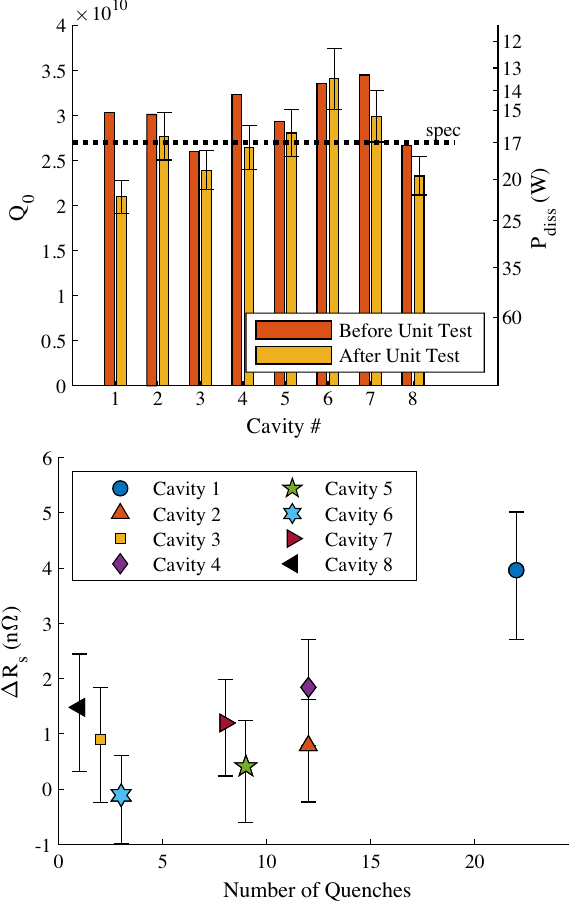
FIG. 15. Q 0 comparison before and after the unit test (top) and the corresponding changes in surface resistance versus the number of quenches that occurred since the most recent thermal cycle (bottom).